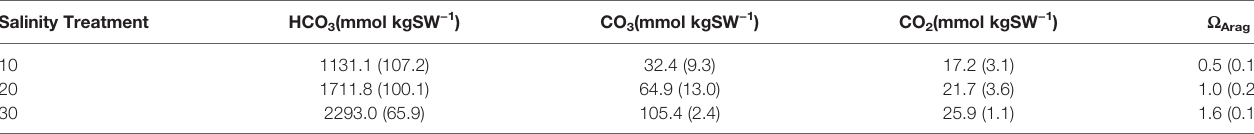
TABLE 2 | Carbonate chemistry parameters for salinity treatments used in laboratory experiments. Salinity Treatment